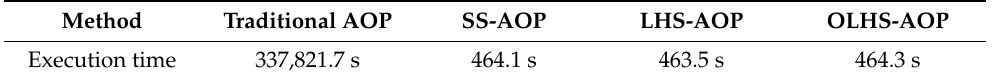
Table 7. Execution time of different methods for the response analysis of double-V NPR